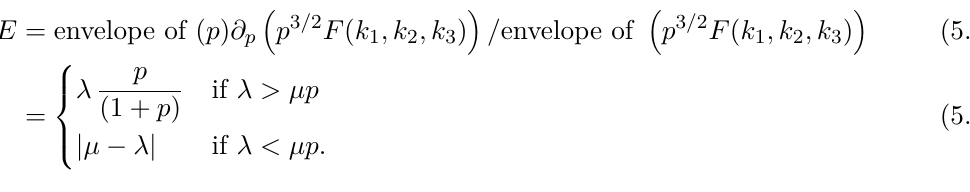
Figure 6. Comparison of the full analytic form evaluated in appendix B (blue) to the large λ approximation (yellow) and large p approximation (green) for M the oscillatory form of the dimensionless NG function F and (b) the non-analytic exponent E . We clearly see that as the degree of squeezing is changed the full bispectrum switches between the above two